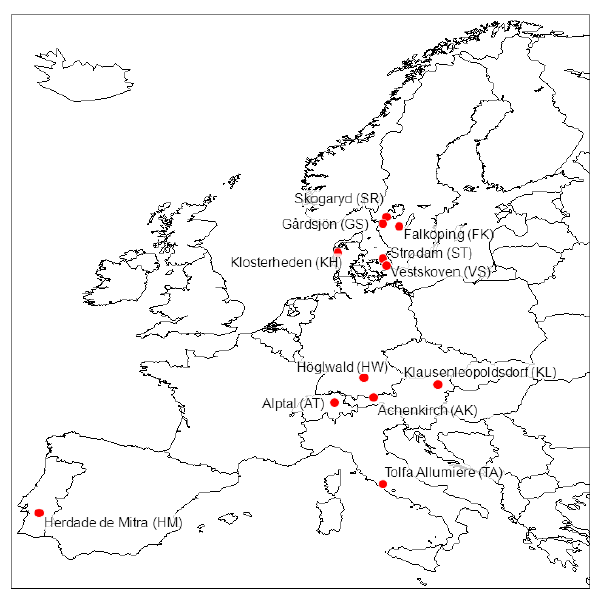
Fig. 1. Forest change sites in the NitroEurope